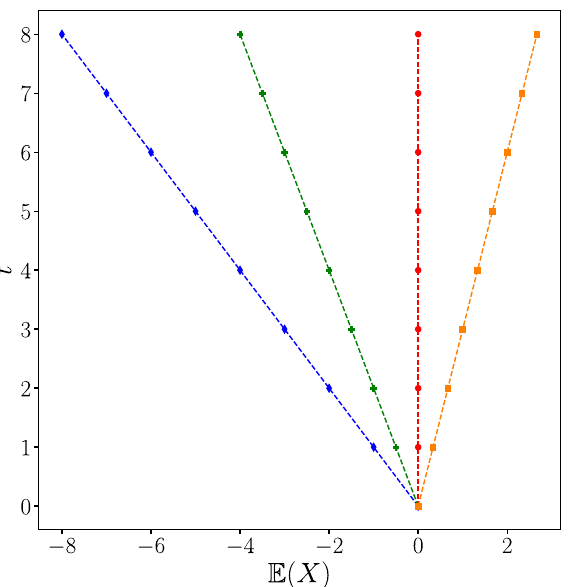
Figure 3. Mean trajectory of the walker for different values of v . Points represents the theoretical prediction, the dashed line coincides with the numerical